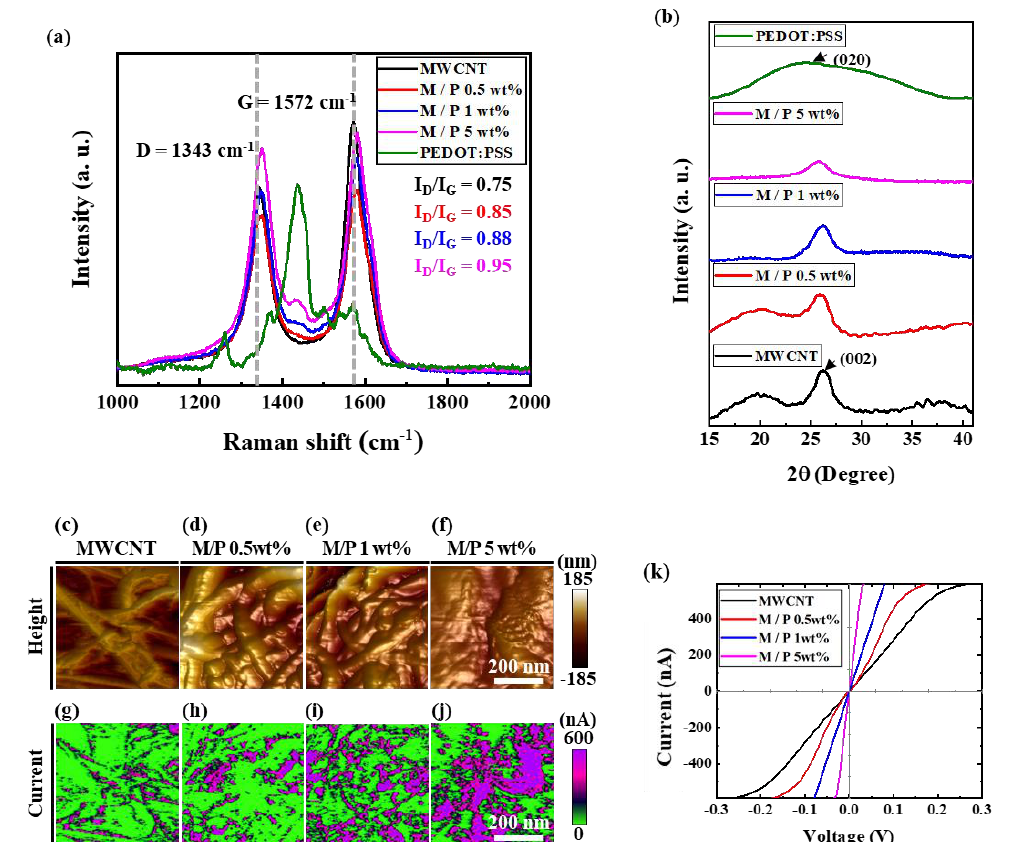
Figure 4. ( a ) Raman and ( b ) XRD spectra of pristine MWCNTs and MWCNTs coated with 0.5, 1, and 5 wt% PEDOT:PSS. Topographic images of ( c ) pristine MWCNTs and MWCNTs coated with ( d ) 0.5 wt%, ( e ) 1 wt%, and ( f ) 5 wt% PEDOT:PSS. Current mapping for ( g ) pristine MWCNTs and MWCNTs coated with ( h ) 0.5 wt%, ( i ) 1 wt%, and ( j ) 5 wt% PEDOT:PSS. ( k ) I-V curves for pristine and 0.5 wt%, 1 wt%, and 5 wt% PEDOT:PSS-coated MWCNTs.